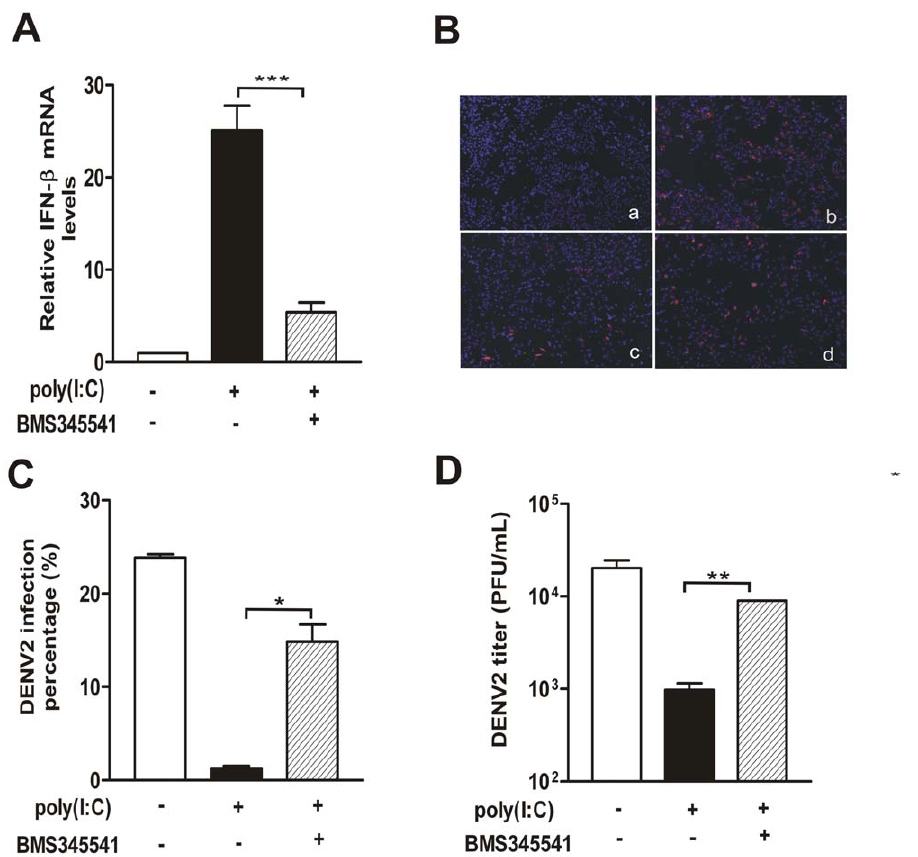
Figure 5. IKK inhibitor reversed the IFN- b induction and virus replication suppression mediated by poly(I:C) pretreatment. HepG2 cells were incubated in control or IKK inhibitor for 30 min before poly(I:C) pretreatment and virus infection. (A) Cells were harvested for measurement of IFN- b expression level; (B) Immunofluorescence microscopy. Cells were fixed at 24 h p.i. and incubated with DENV2 prM antibody. Panel a, mock infected; b, DENV2; c, DMSO + poly(I:C) + DENV2; d, BMS345541 + poly(I:C) + DENV2; (C) Percentages of positive-stained cells determined by PicCnt 100 6 ; (D) Extracellular viral production determined by TCID50. Supernatants were harvested at 24 h p.i. and titered on C6/36 cells. Error bars represent the standard error of mean from the average of three experiments. Student’s t test, *, p , 0.05; **, p , 0.01; ***, p , 0.001.